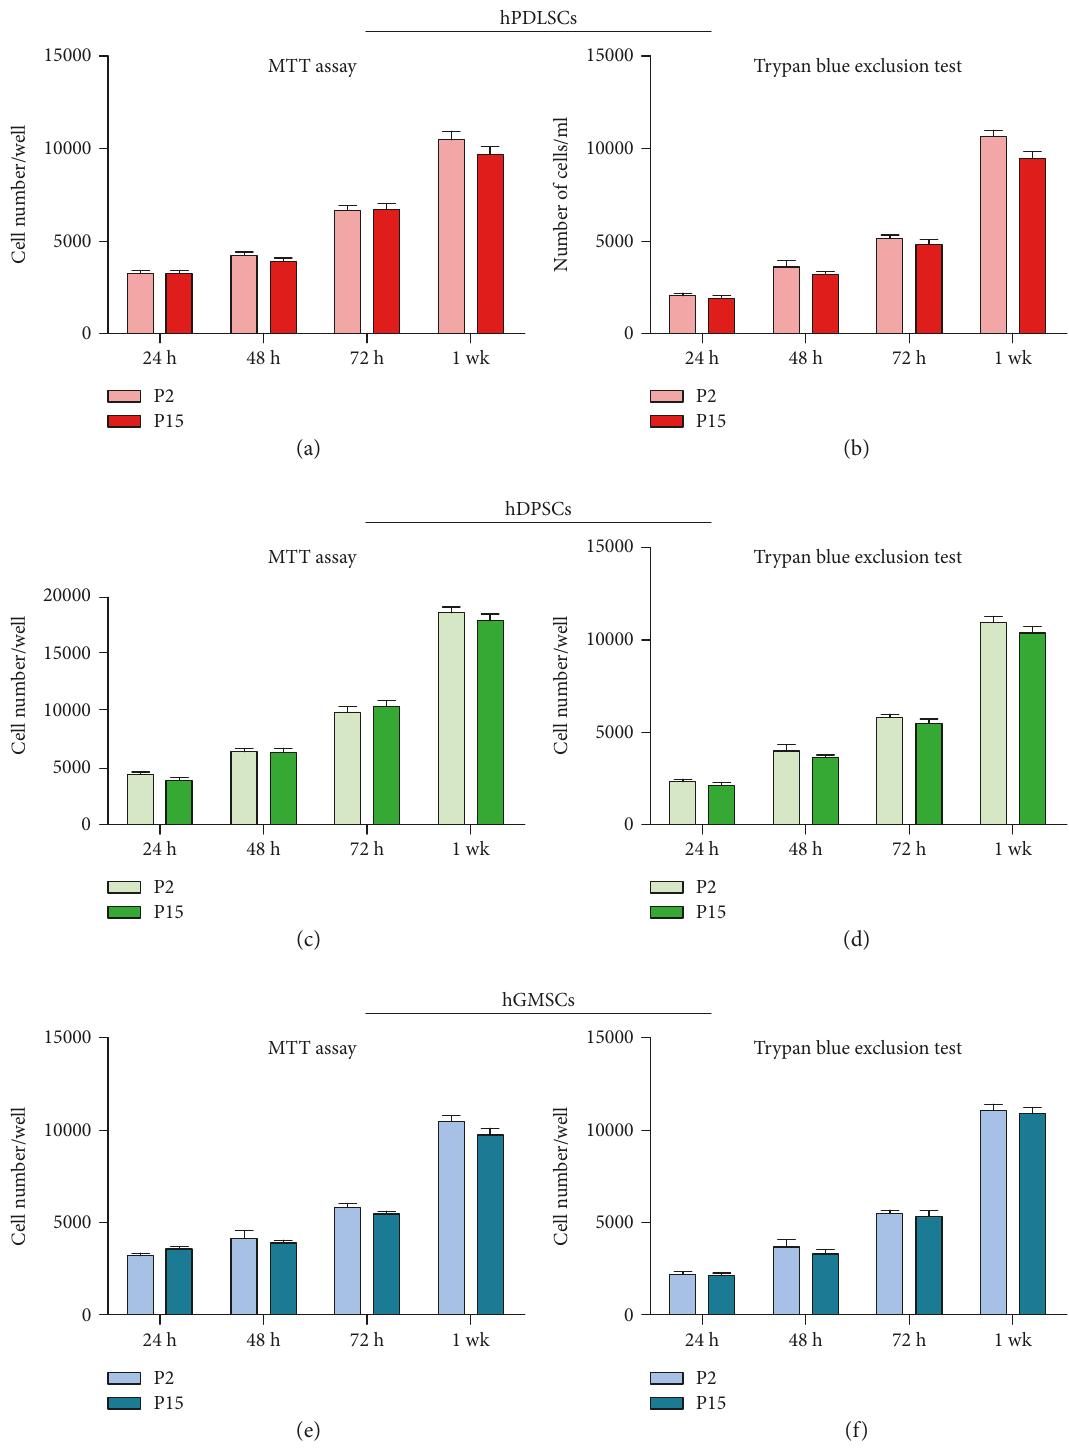
Figure 1: Cell viability and proliferation. Graphs show the proliferation rate at di ff erent time of each cell primary cultures at P2 and P15. Bar graphs display the exponential growth pattern of (a) hPDLSCs, (c) hDPSCs, and (e) hGMSCs, evaluated by MTT assay. Proliferation rate of (b) hPDLSCs, (d) hDPSCs, and (f) hGMSCs, performed by Trypan blue exclusion test, con fi rmed MTT assay results. Cells showed a logarithmic proliferation trend at P2 and P15 without any statistically signi fi cant di ff erences. The y -axis shows cell number and x -axis shows culture time. Results in each bar graph are the composite data from experiments performed in triplicate (mean ±